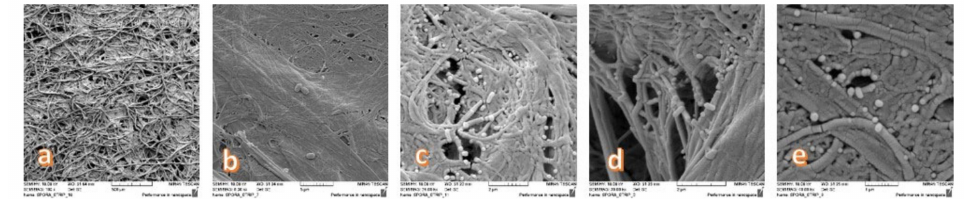
Figure 2. Bacterial endospore Geobacillus Stearothermophilus and Bacillus Atrophaeus (MesaLabs, Inc. USA) images were taken with a scanning electron microscope (SEM). Magnification: ( a ) 100 × ; ( b ) 6000 × ; ( c ) 24,000 × ; ( d ) 30,000 × ; ( e ) 40,000 × .